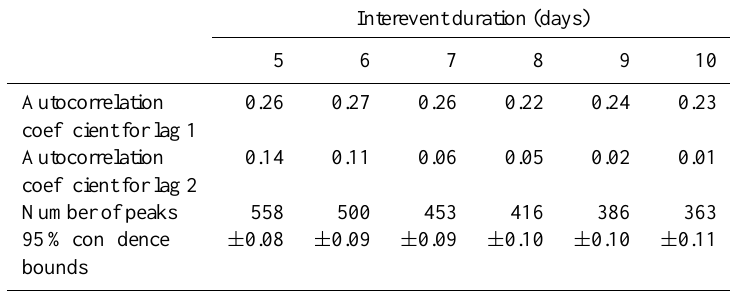
Table 1. Autocorrelation values for lag 1 and lag 2 of the Alt Llobregat sub-basin, given different interevent duration values.